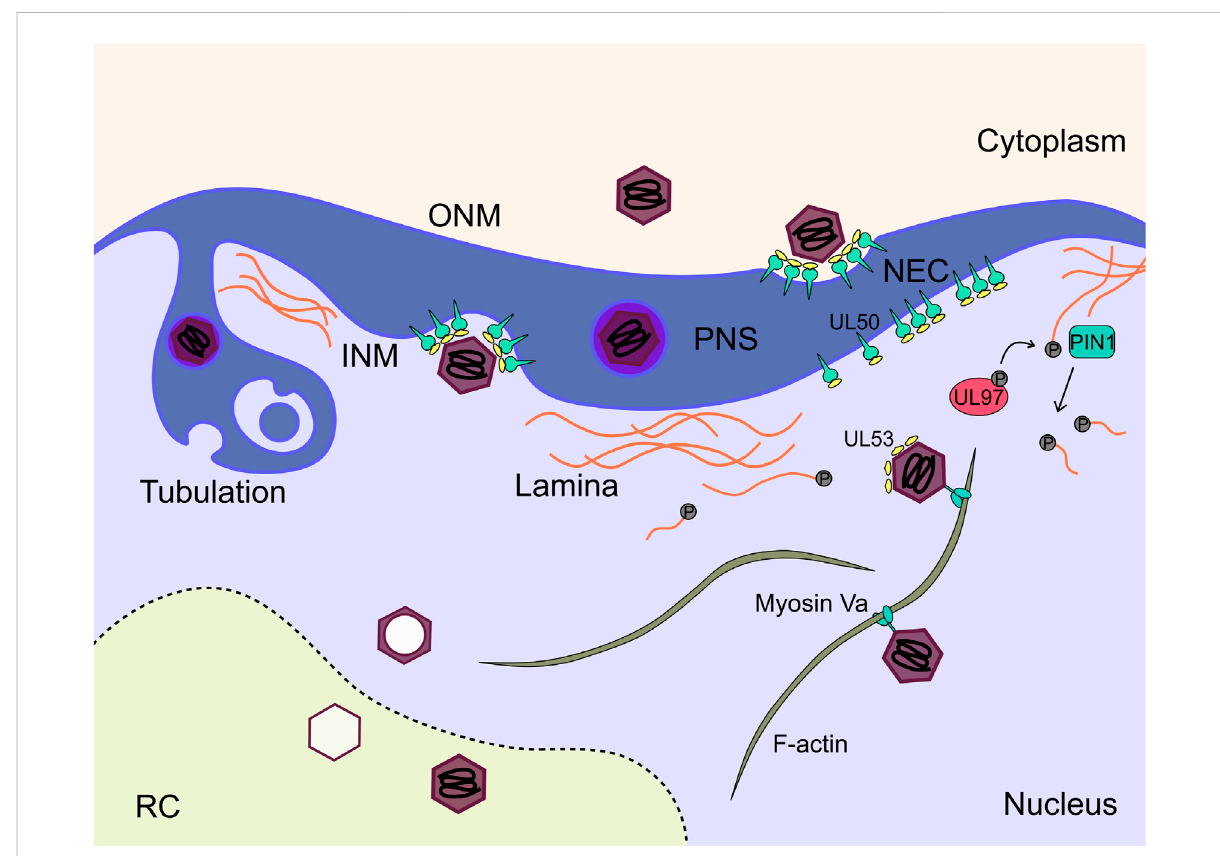
FIGURE 8 Maturecapsidstraversebothnuclearmembranestoenterthecytoplasmforsubsequentmaturation.TheNECconsistingofUL50andUL53acts asanorganisationalhubontheINMtorecruithostandviralproteins tofacilitatethisstep.Additionally,thenuclearlaminaposesaphysicalbarrierfor exitingcapsids.ThelaminsarephosphorylatedbytheviralkinaseUL97andsubsequentlydepolymerise.Ccapsidstravelalongnuclearactin fi laments to the nuclear membrane where they undergo envelopment at the INM mediated by the NEC, and subsequent fusion with the ONM to release thenascentcapsidintothecytoplasm.NEC,nuclearegresscomplex;INM,innernuclearmembrane;ONM,outernuclearmembrane;RC,replication compartment; PIN1, peptidyl-prolyl cis-trans isomerase NIMA-interacting